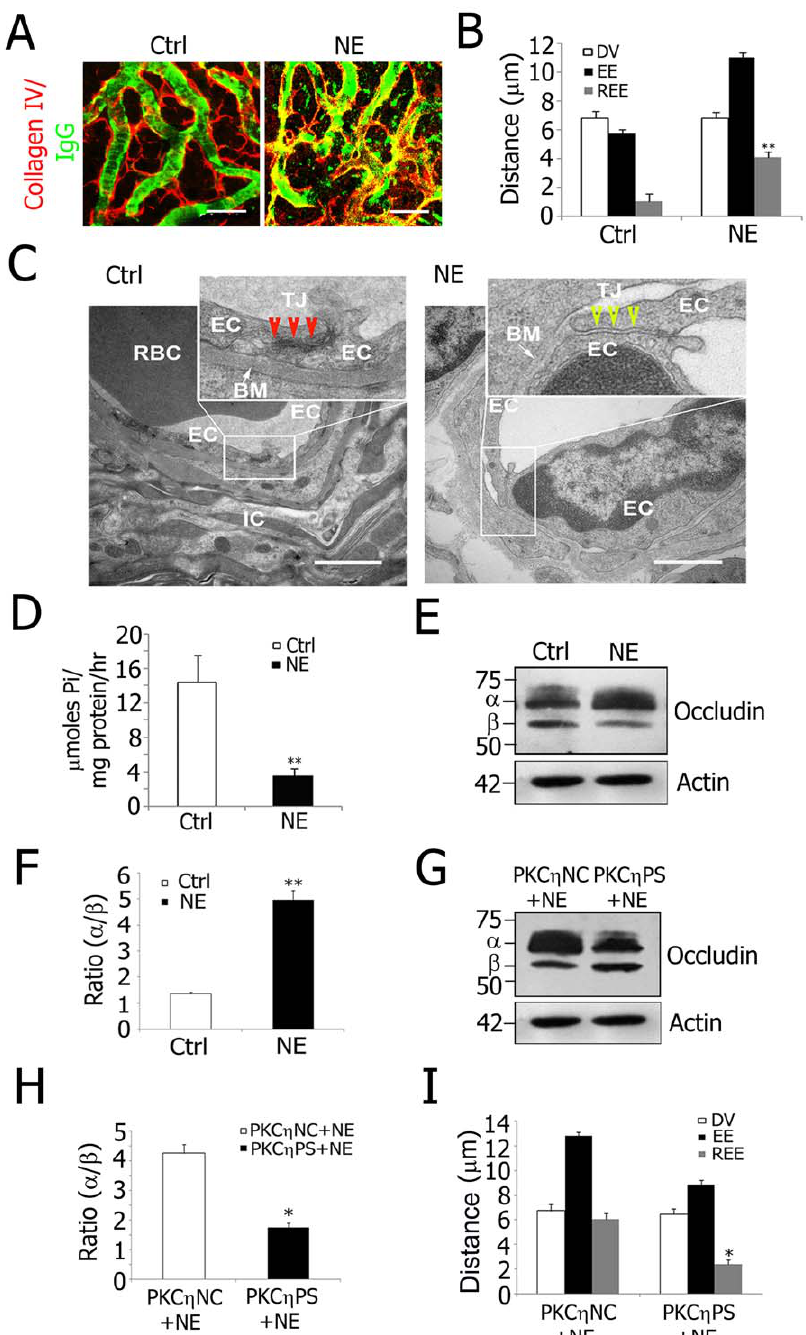
Figure 6. PKC g phosphorylated occludin from decreased Na + /K + -ATPase activity is a mechanism for noise-induced blood-labyrinth barrier disruption. A, Confocal images of IgG leakage from capillaries in disrupted blood-labyrinth barrier of noise-exposed (NE) animals. Stria vascularis capillary networks were labeled with anti-collagen type IV (red) and anti-serum protein IgG (H + L, green) antibodies. IgG was confined in normal stria vascularis capillaries (Left) but not in NE animals (Right). B, REE analysis shows significantly increased blood-labyrinth barrier permeability in NE mice (**P=0.005 , 0.01). REE: relative extension of serum protein IgG extravasation; DV: diameter of the vessels; EE: extension of IgG extravasation. C, Transmission electron microscope images show alterations in TJ ultrastructure from NE. TJ contact points were reduced in response to NE (Right, Inset). In contrast, TJ contact points were extensive in control mice (Left, Inset). Insets display higher magnification of TJ between ECs. D, NE caused decreased Na + /K + -ATPase activity in stria vascularis capillaries in NE animals (** P=0.005 , 0.01). E, Immunoblots for occludin from isolated stria vascularis capillaries of control and NE mice. Two bands, hyperphosphorylated a ( , 70 kD) and dephosphorylated b ( , 65 kD), were detected. F, Densitometry of the immunoblot results found a 3.9-fold increase in the ( a / b ) ratio following NE (**P=0.005 , 0.01). G, Immunoblots for occludin from NE mice pre-treated with PKC g NC and PKC g PS. H, A 2.4-fold decrease in the ( a / b ) ratio occurred with PKC g PS pre-treatment (*P=0.022 , 0.05). I, REE analysis confirms decreased permeability in NE mice pre-treated with PKC g PS (*P=0.021 , 0.05). Values in B, D, F, H, and I are mean 6 SEM (n=10). BM: basal membrane; EC: endothelial cell; IC: intermediate cell; RBC: red blood cell; TJ: tight junction. (Scale bars: A, 20 m m; C, 500 nm). doi:10.1371/journal.pone.0016547.g006 PLoS ONE |